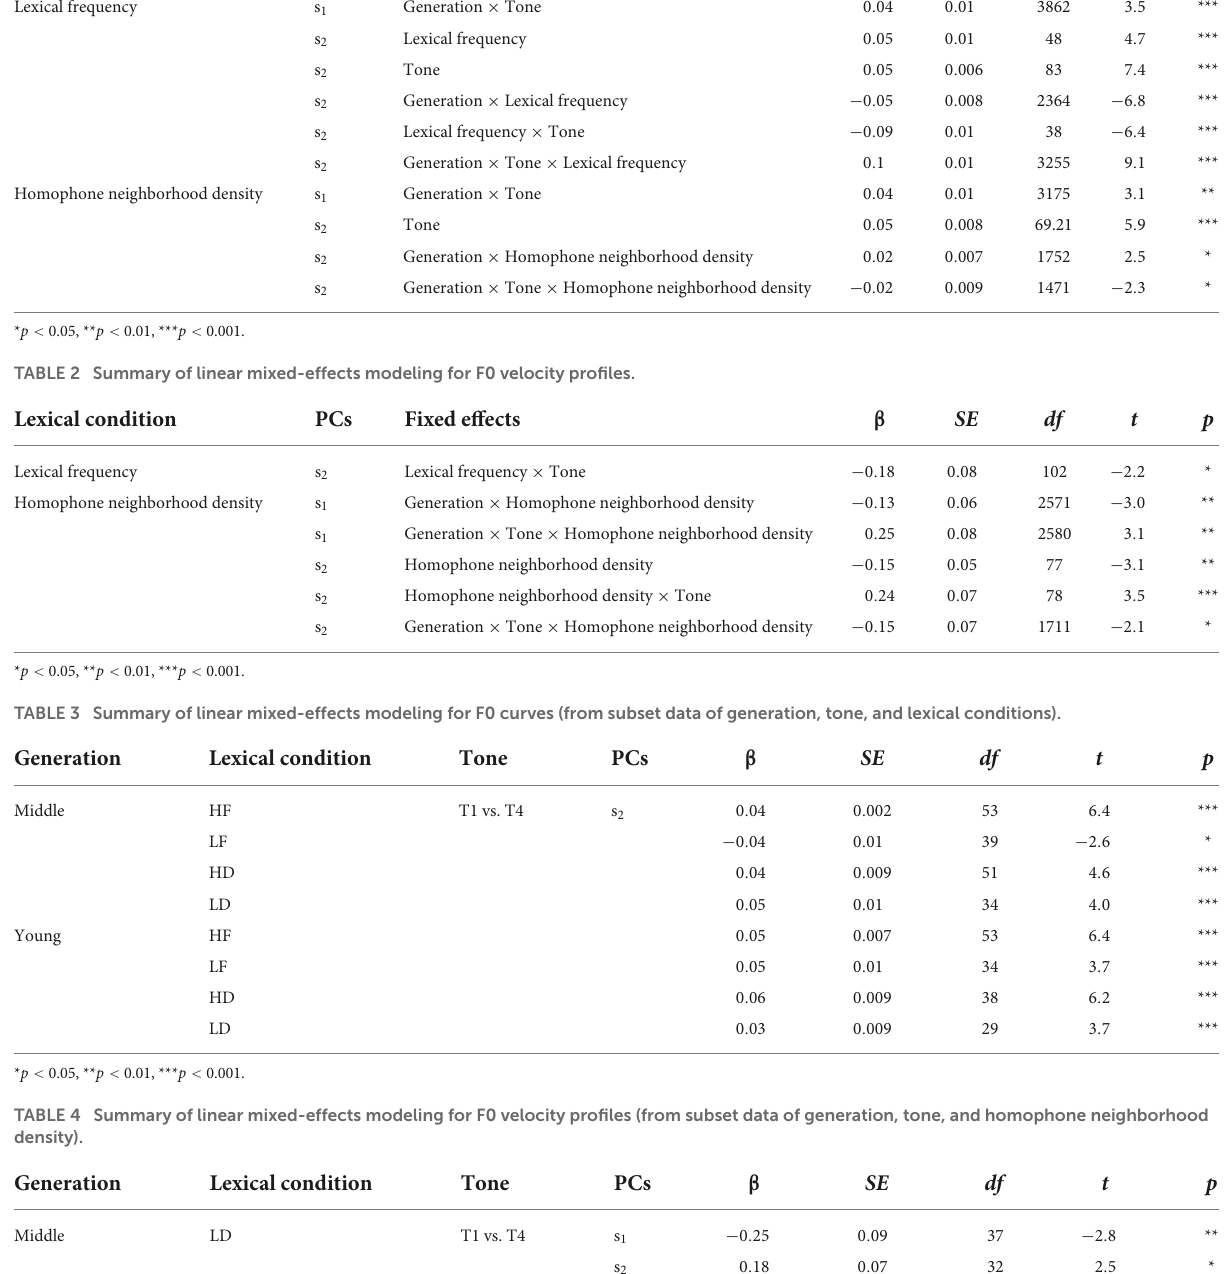
TABLE 1 Summary of linear mixed-effects modeling for F0 curves. Lexical condition